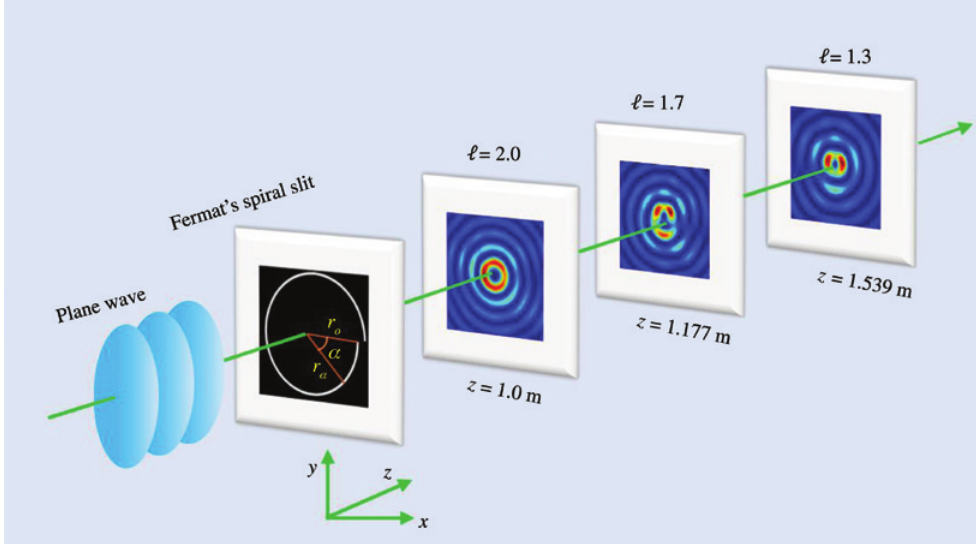
Figure 1: Geometry and notation of the spiral slit for achieving an anomalous Bessel vortex